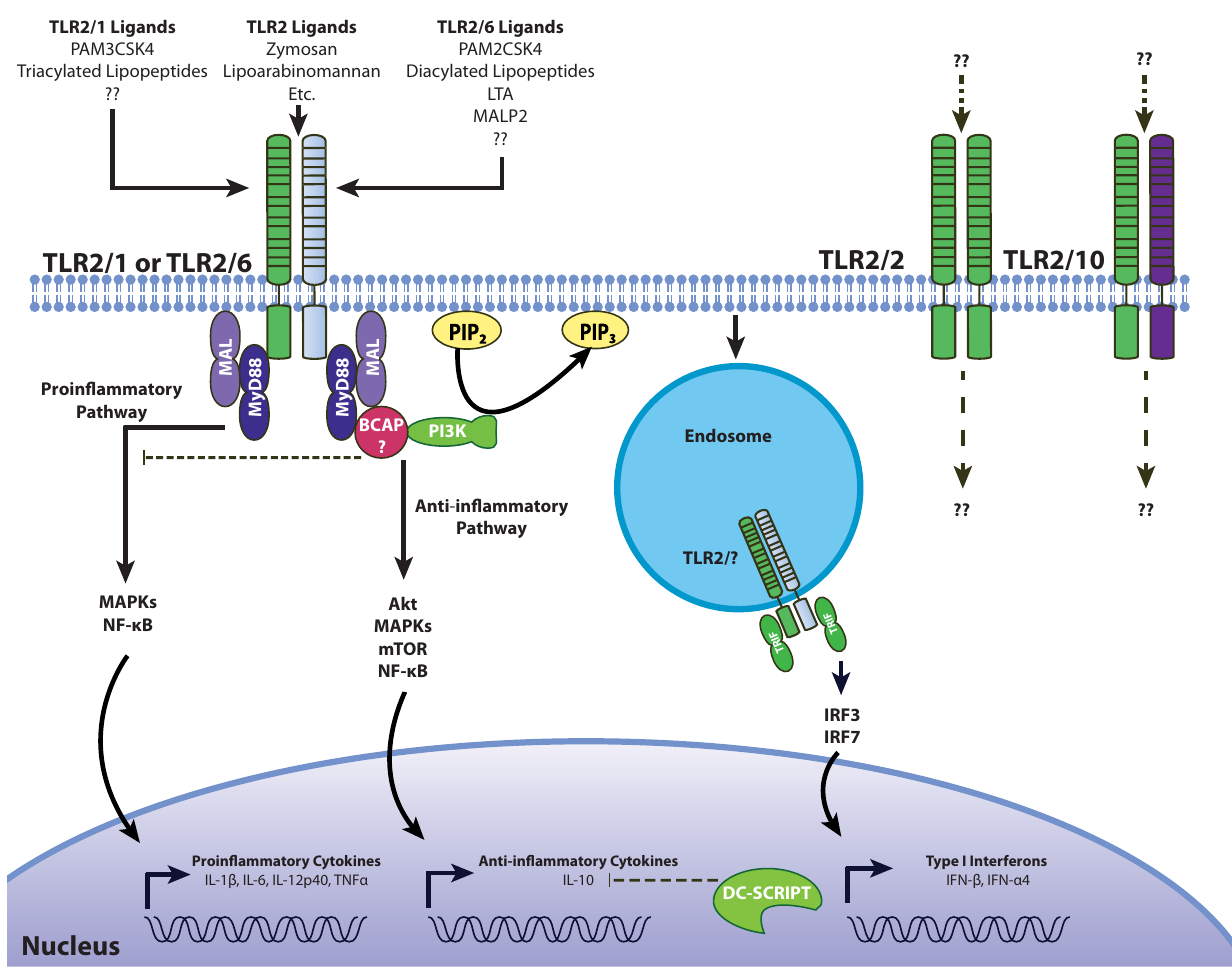
FIGURE 2 | Model for pro- and anti-inflammatory signaling throughTLR2 . LikeTLR4, pro-inflammatory signaling throughTLR2 involves the recruitment of the adaptors MyD88 and MAL/TIRAP to induce inflammatory cytokines through ERK, JNK, and NF- κ B. BCAP interacts with both MyD88 and MAL to recruit PI3K, which then phosphorylates Akt, inducing the secretion of anti-inflammatory IL-10.The involvement of DC-SCRIPT in suppressing